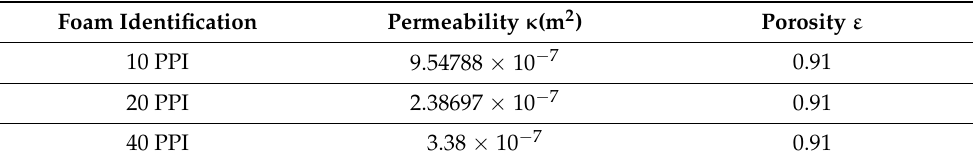
Table 1. Properties of the Metallic aluminum Foam. Data from